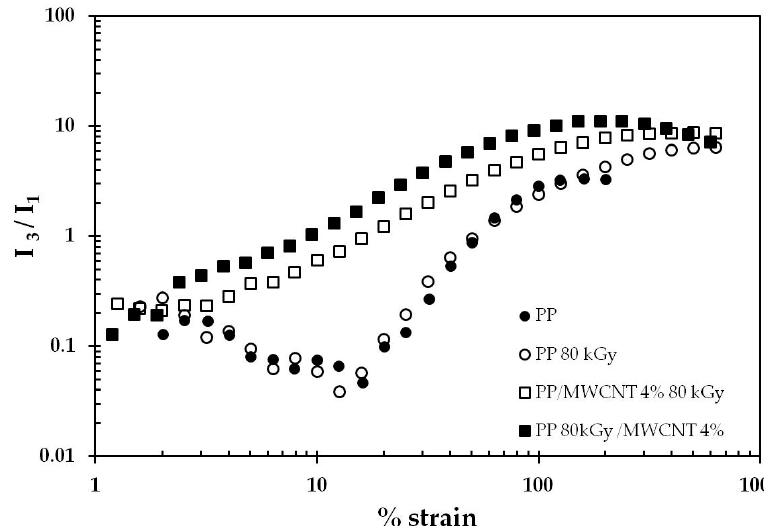
Figure 6. LAOS results (see text) for PP, irradiated PP (PP 80 kGy), Protocol A nanocomposite (PP/MWCNT 4% 80 kGy) and Protocol B nanocomposite (PP 80 kGy/MWCNT 4%). The values of I 3 /I 1